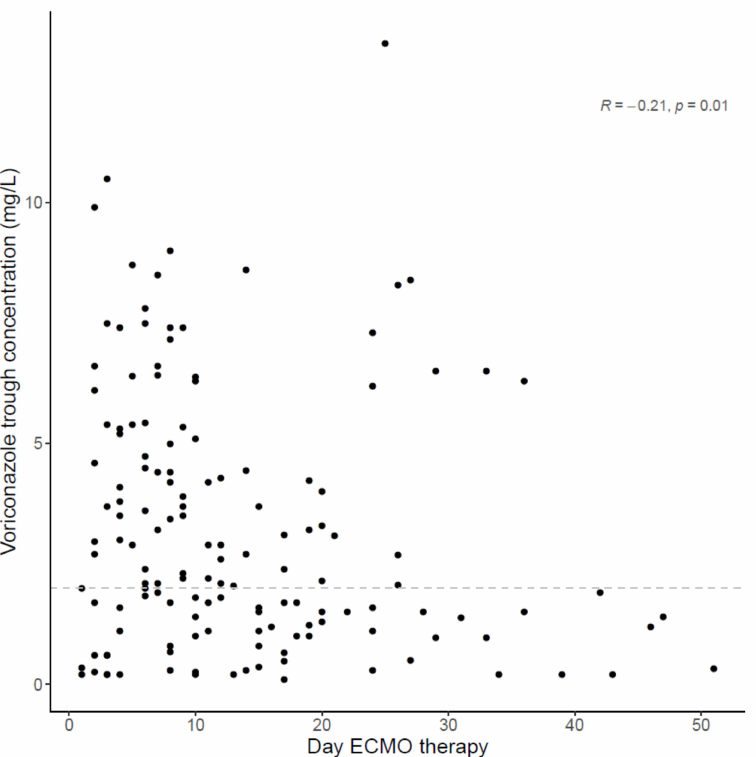
Figure 3. Voriconazole trough concentration in function of the day of ECMO with spearman- coefficient and p -value ( n = 145). The dashed line represents the lower limit concentration of 2